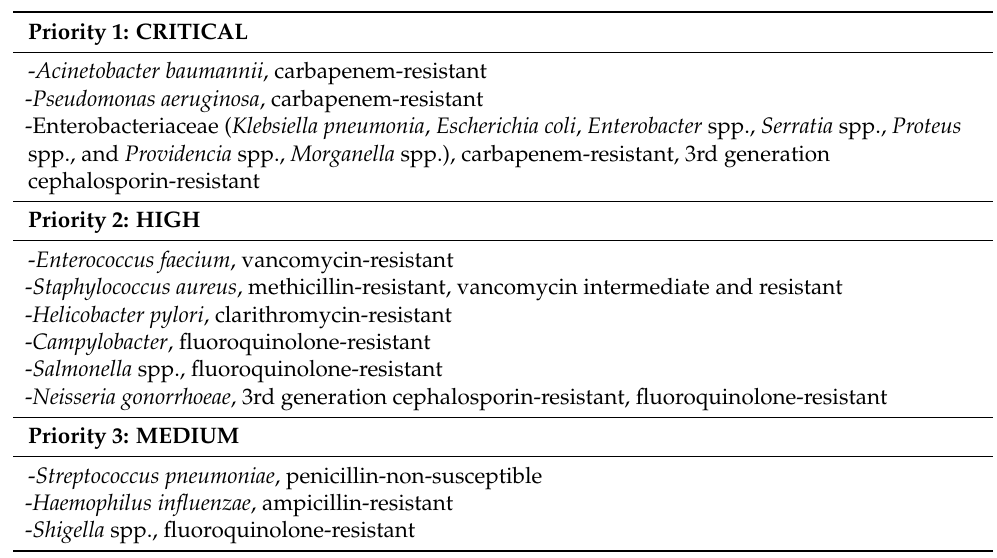
Table 1. Global priority list of antibiotic-resistant bacteria (Adapted from: https://www.who.int/ medicines/publications/WHO-PPL-Short_Summary_25Feb-ET_NM_WHO.pdf?ua=1 (accessed